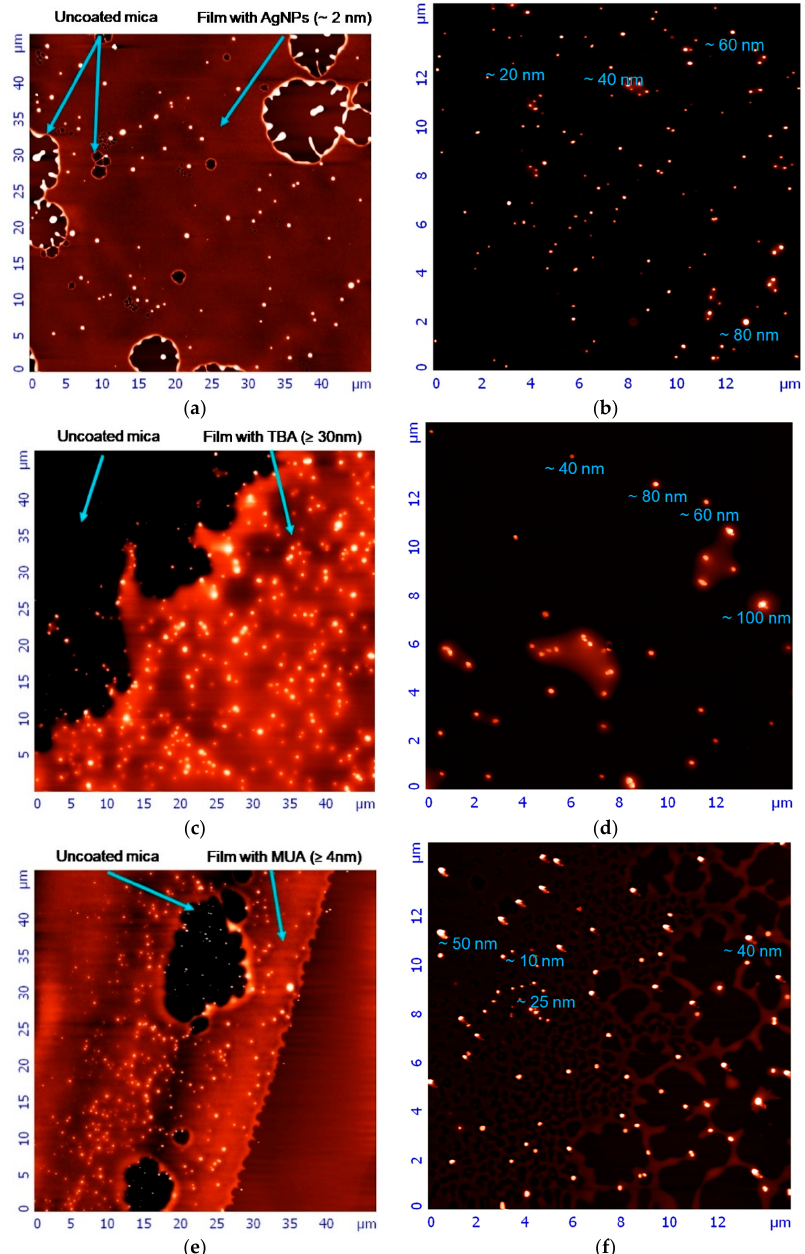
Figure 2. Atomic force microscopy (AFM) images of newly synthesized AgNPs. ( a ) Images of naked AgNPs precipitated on a mica after 100-fold dilution. Arrows indicate the uncoated mica and the polymer layer height; ( b ) images of naked AgNPs precipitated on the uncoated mica after 100-fold dilution; ( c ) images of AgNP-TBA nanoparticles precipitated on a mica from the original solution. Arrows indicate the uncoated mica and the polymer layer height; ( d ) images of AgNP-TBA nanoparticles precipitated on the uncoated mica from the original solution; ( e ) images of AgNP-MUA nanoparticles precipitated on a mica after 30-fold dilution. Arrows indicate the uncoated mica and the polymer layer height; ( f ) images of AgNP-MUA nanoparticles precipitated on the uncoated mica after 30-fold dilution. Nanoparticles’ heights are given below measured